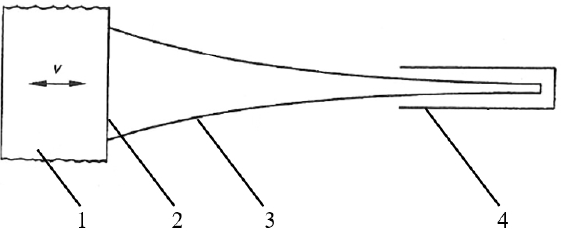
Figure 2. Broadband vibration absorber (BVA) according to Bschorr/Albrecht (1979) [6–8]: 1 = structure to be damped, 2 = base area A o , 3 = tapered waveguide and 4 = damping layer. A one-dimensional absorber with base area A o [m 2 ], density ρ o [kg/m 3 ] and longitudinal wave velocity c o [m/s] achieves a maximum resistance R o = ρ o c o A o [kg/s]. Coupled to a vibrating structure with mean velocity v [m/s] causes the damping power N → 1 / 2 R o v 2